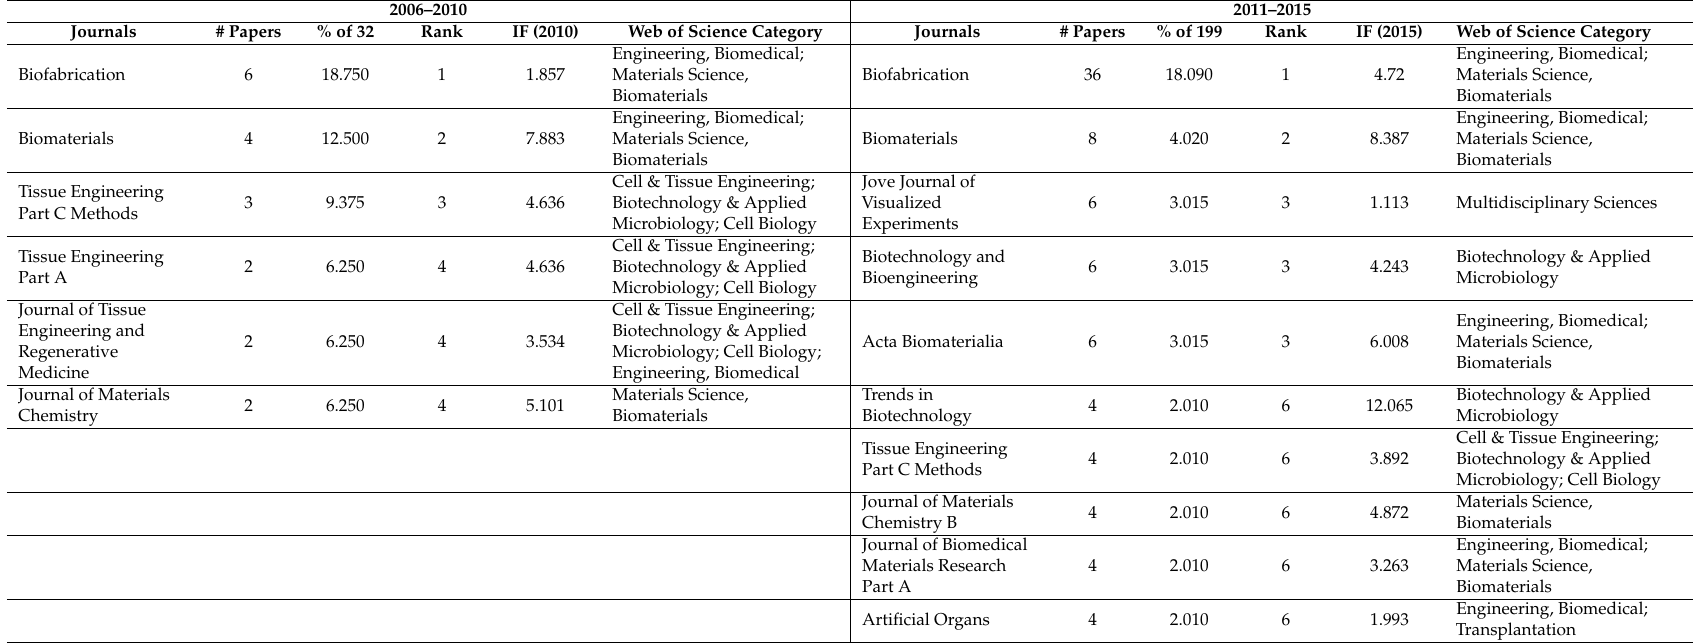
Table 3. Top-6 journals most abundant in bioprinting research papers and their impact factors for 2006–2010 and 2011–2015 periods (IF: impact factor). The minimum record count was publishing 2 papers in 2006–2010 (13 journals were hidden), and 3 in 2011–2016 (81 journals were